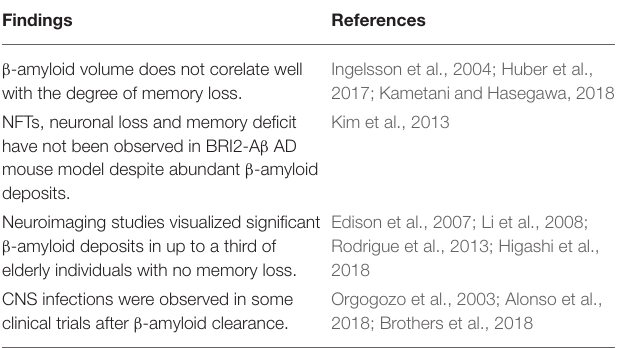
TABLE 1 | Perceived inconsistencies in the amyloid cascade hypothesis emphasized by novel